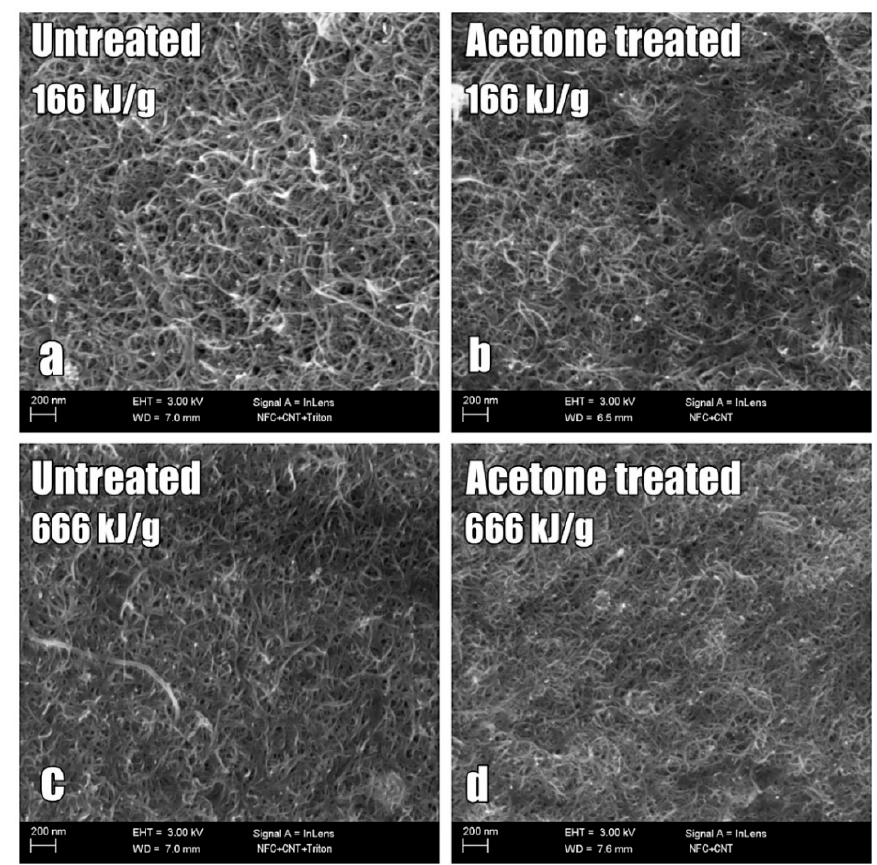
Figure 4. SEM imaging of NFC-CNT nanocomposite films surface (166 and 666 kJ/g) containing surfactant ( a , c ) and after removal of surfactant Triton X-100 by washing them in acetone ( b , d ).